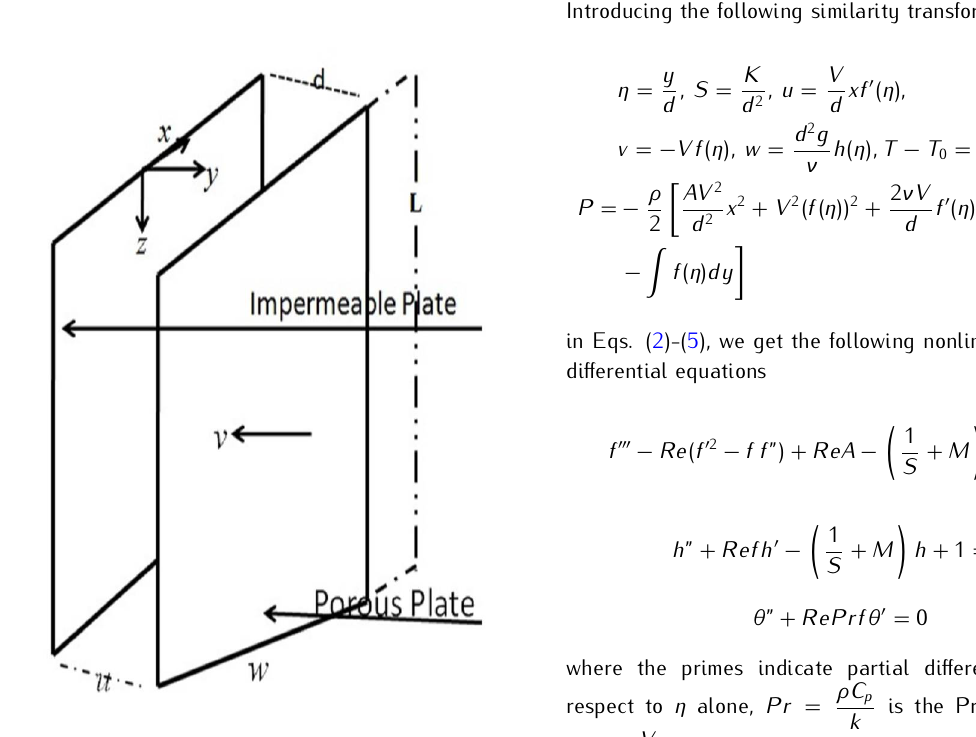
Figure 1. Physical model and coordinate